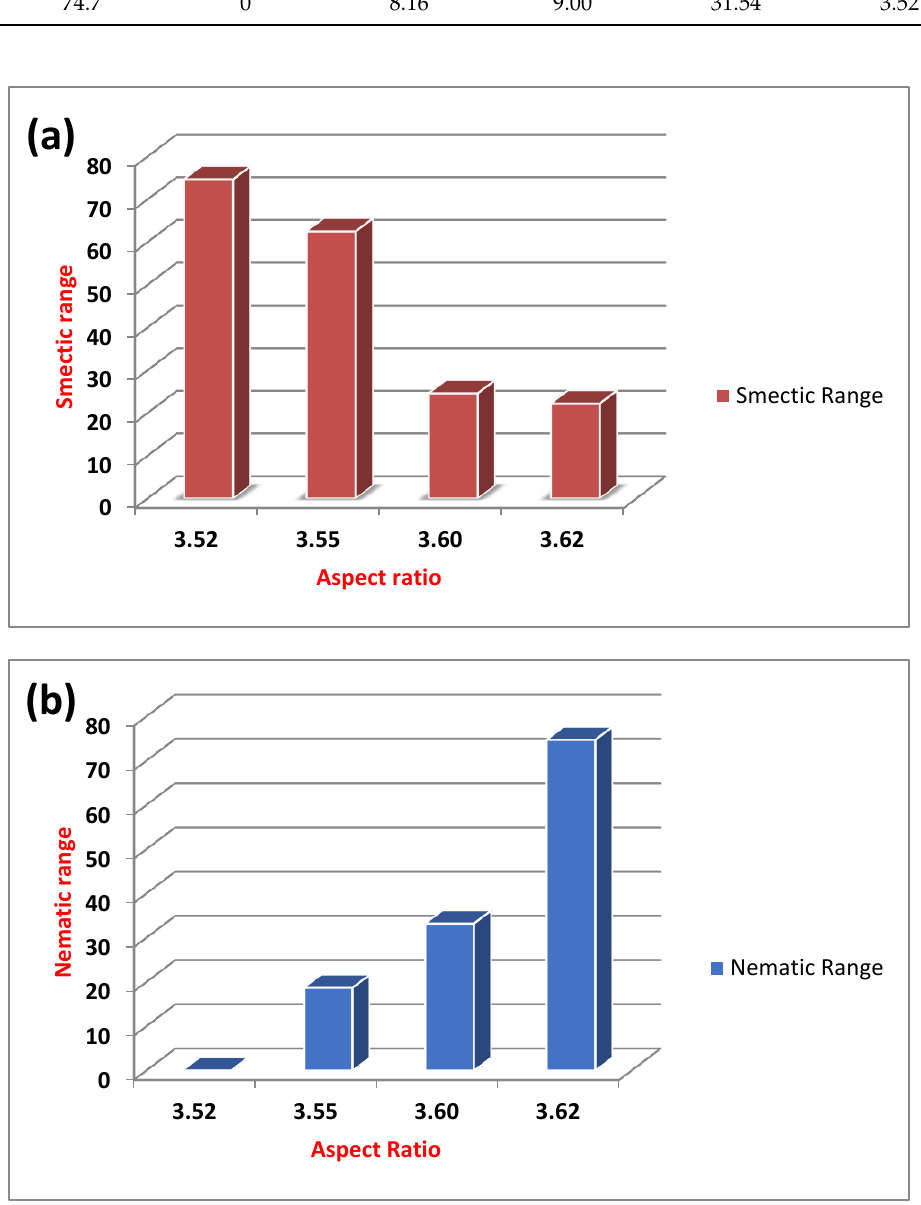
Figure 4. The relation between the aspect ratio and nematic ( a ) and smectic ( b ) total ranges of the investigated compounds